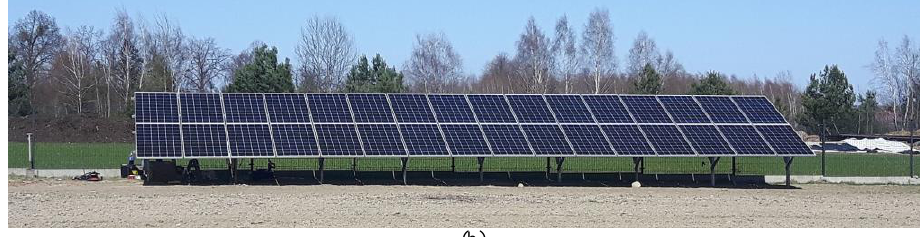
Fig. 2. PV panels: (a) on the roof; (b) on the ground [3].